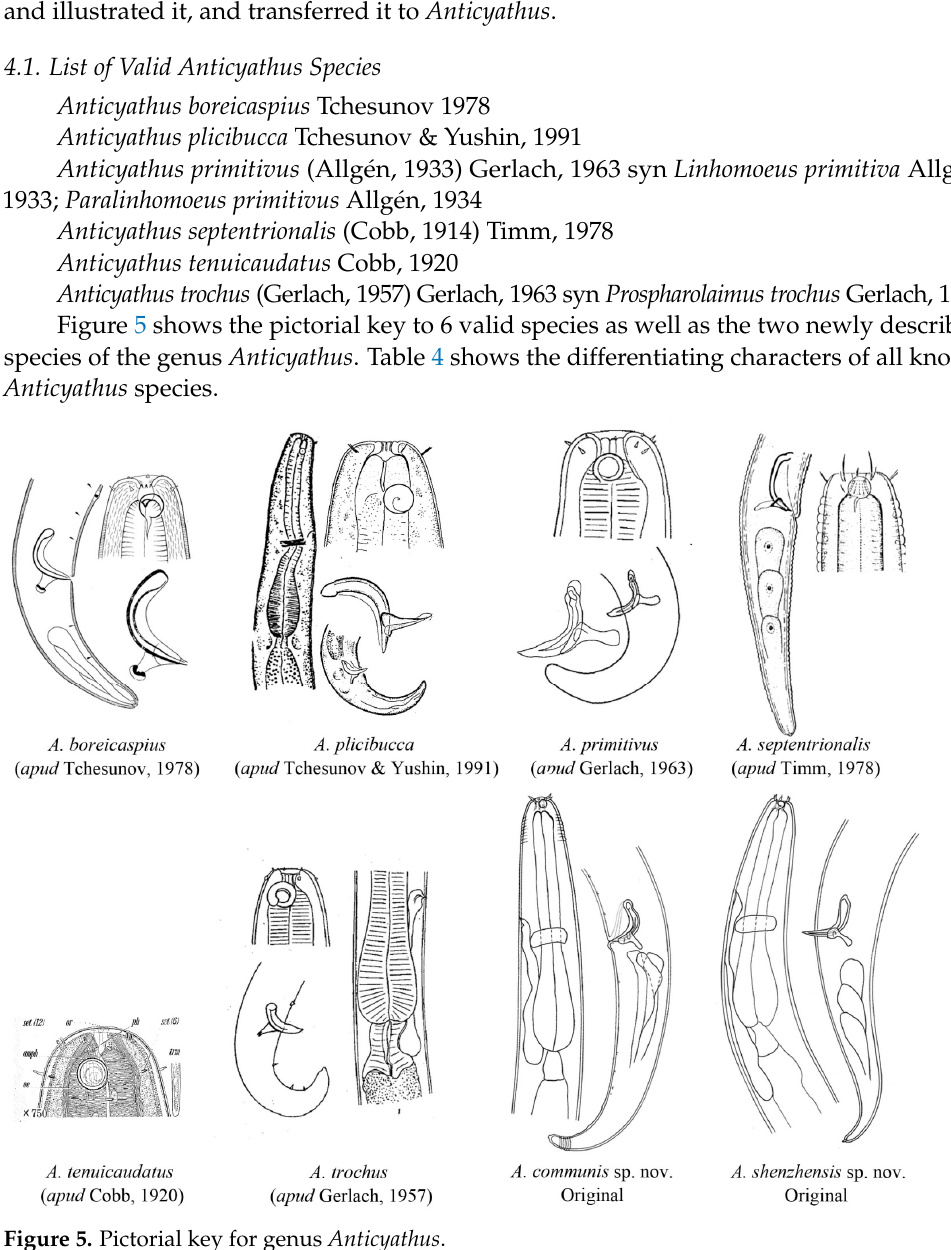
Figure 5. Pictorial key for genus Anticyathus .